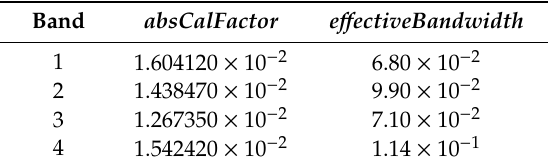
Table 3. Radiation scaling transformation parameters of